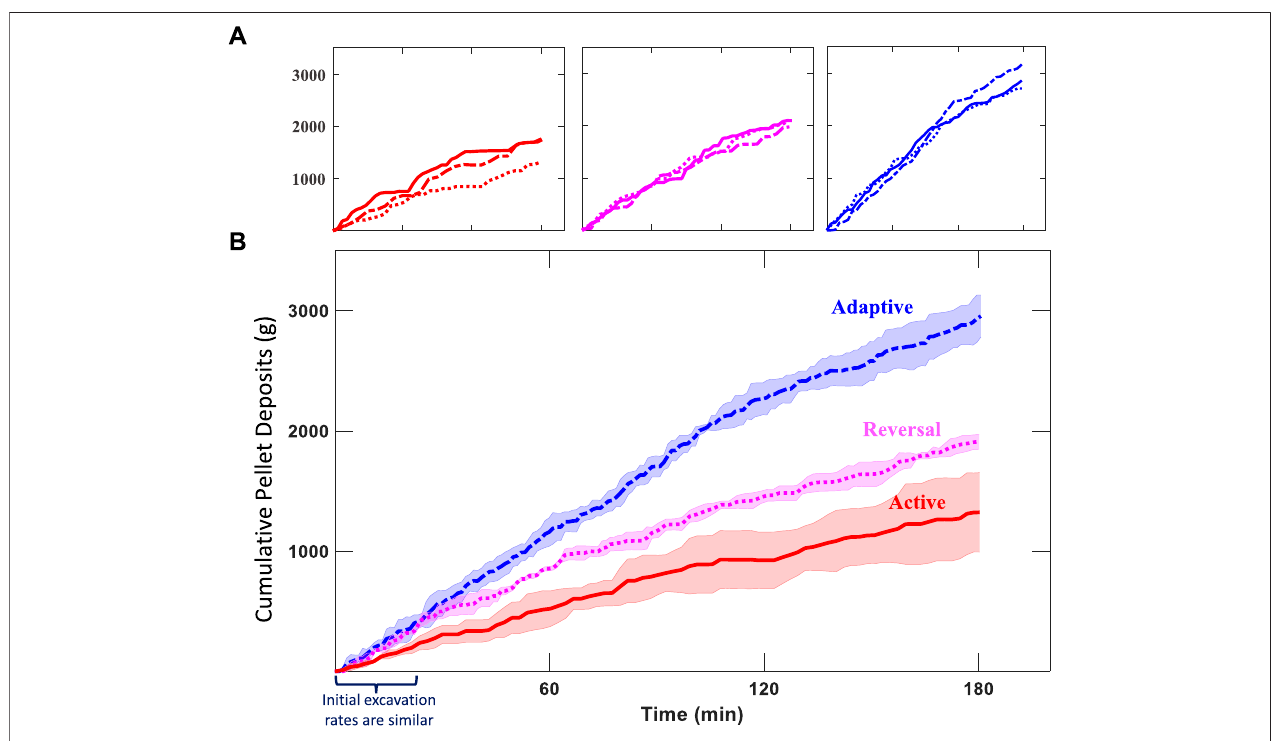
FIGURE 6 | Excavated Pellets vs. Time for three different protocols. Active protocol: all robots have an entrance probability of 1.0 but a reversal probability of 0; Reversalprotocol:allrobots haveanentrance probabilityof1.0and reversalprobabilityof0.8; Adaptiverule: entranceprobabilityisafunction ofinversesquare oftunnel length,whilereversalprobabilityisafunctionofinversesquare-rootoftunnellength. (A) Individualtrialcomparisonofexcavationexperiments (B) Meanexcavatedpellets, shaded areas correspond to standard deviation from three experiments.